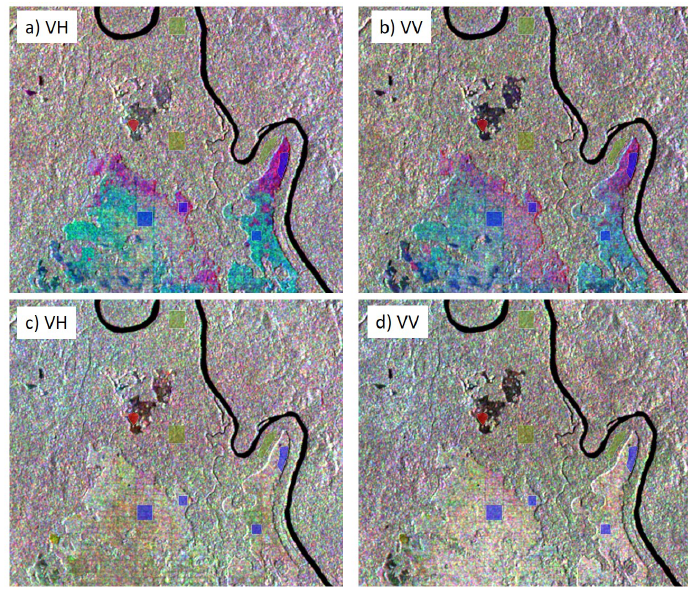
Figure 8. Temporal RGB compositions during the wet season of the zoomed view in Figure 3: ( a ) VH channel combining 2015 (R), 2016 (G) and 2017 (B); ( b ) VV channel combining years 2015 (R), 2016 (G) and 2017 (B); ( c ) VH channel combining 2019 (R), 2020 (G) and 2021 (B); and ( d ) VV channel combining 2019 (R), 2020 (G) and 2021 (B). Red, light green and blue polygons indicate the areas under